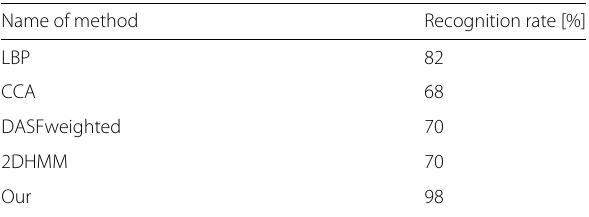
Table 4 Comparison to other face recognition methods base on